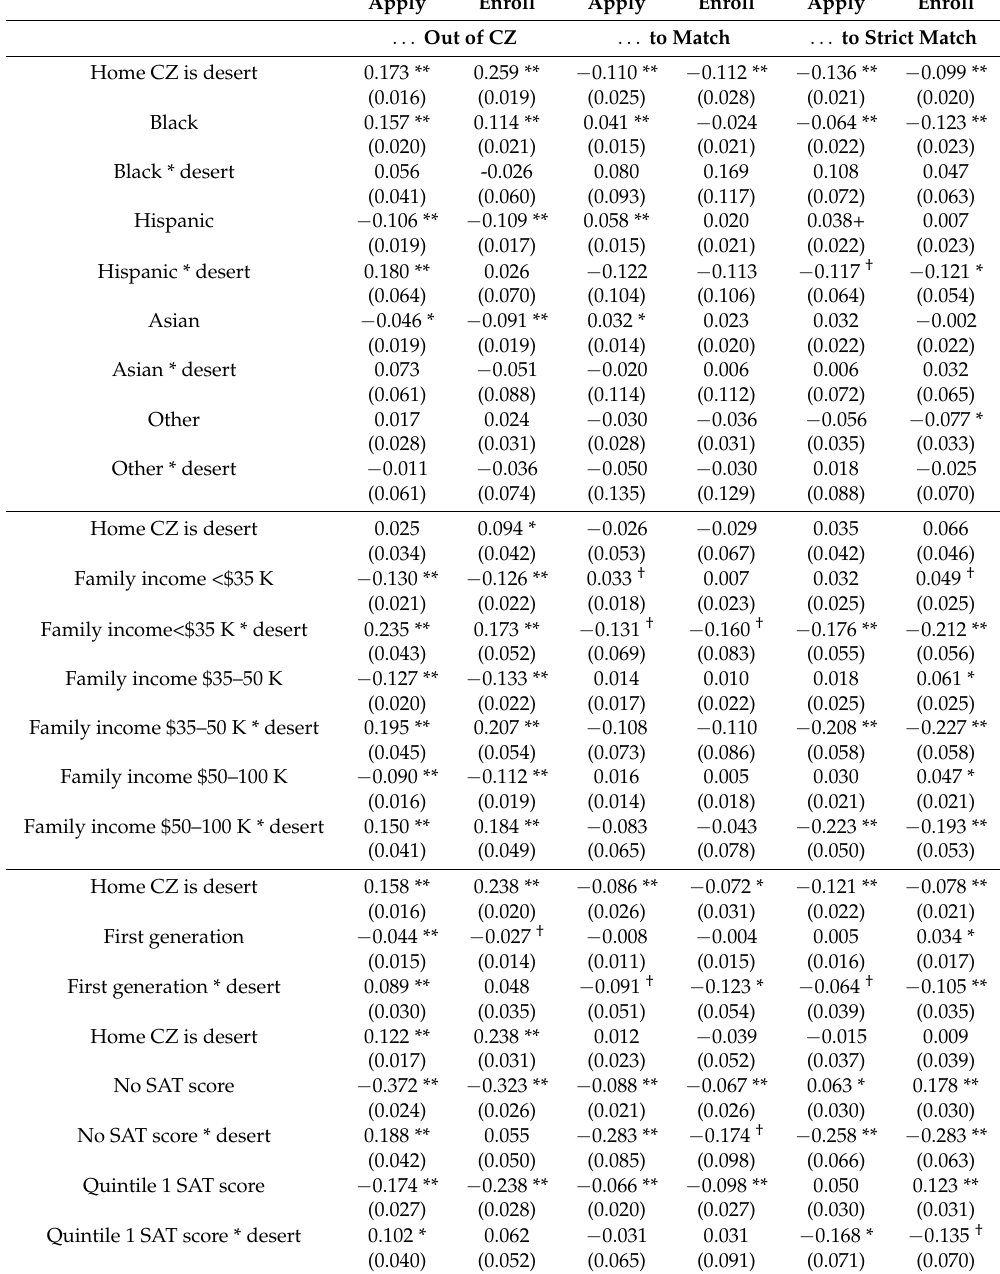
Table 9. Heterogeneous relationships between living in access or match desert and application and enrollment